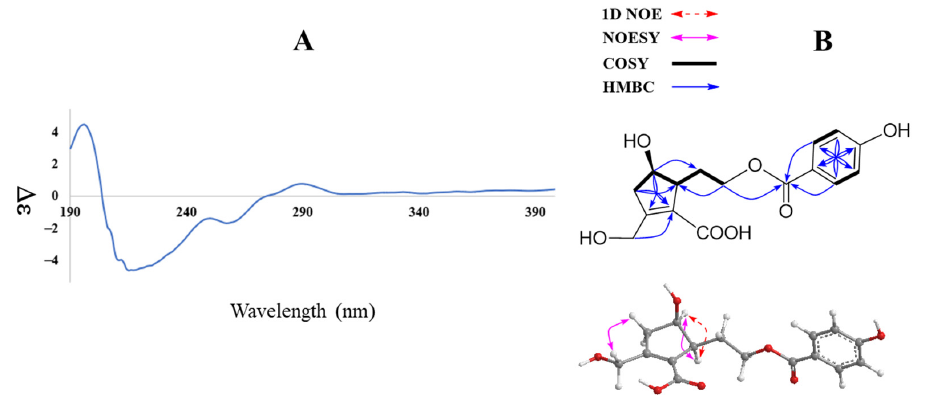
Figure 2. CD spectrum ( A ) and key HMBC, COSY, 1D NOE, and NOESY ( B ) correlations of compound 1 .